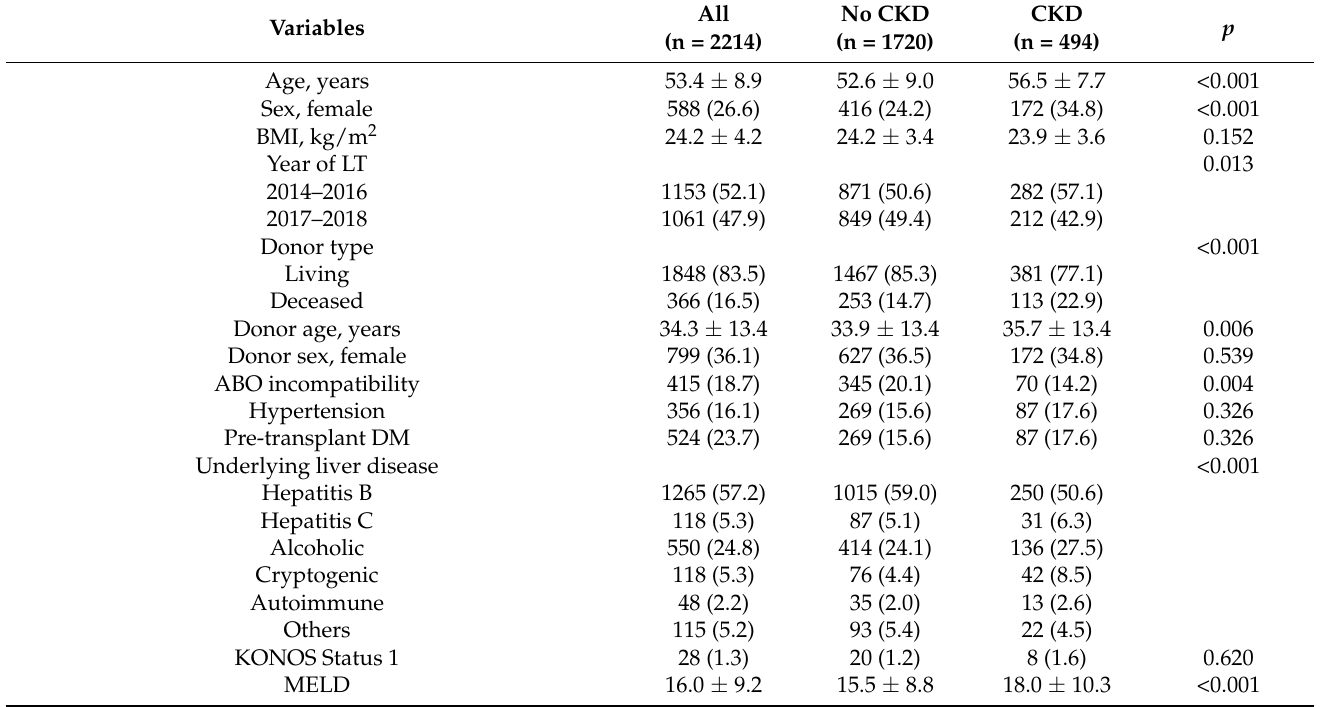
Table 1. Baseline characteristics of the study population. Variables